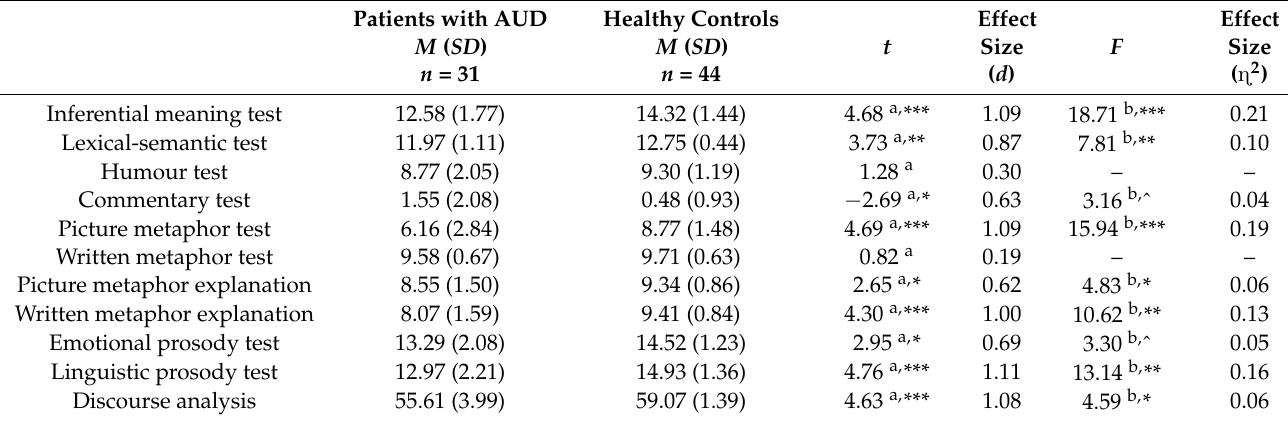
Table 2. Differences in correct answers in Right Hemisphere Language Battery (RHLB) between patients with alcohol use disorder (AUD) and healthy controls.